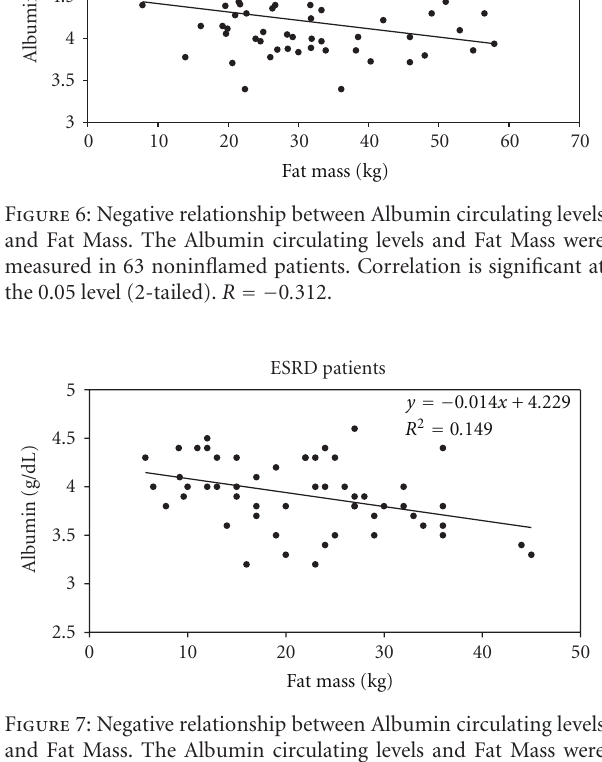
than in controls, either in subcutaneous or intra-abdominal adipose tissue